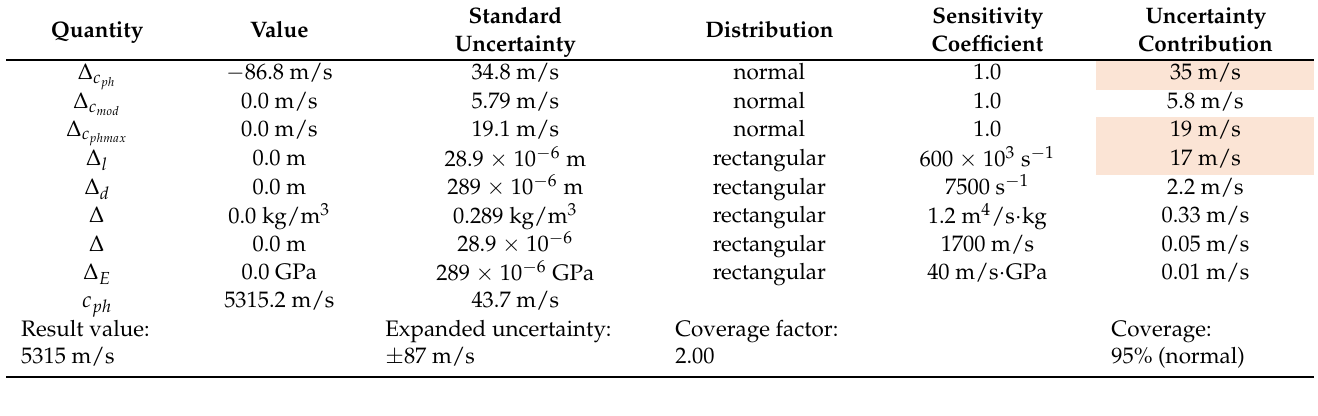
Table 6. The uncertainty budget of the combined uncertainty of the reconstructed frequency range (137.5–186.5) kHz for the S 0 mode. The shadows represent the dominant components.